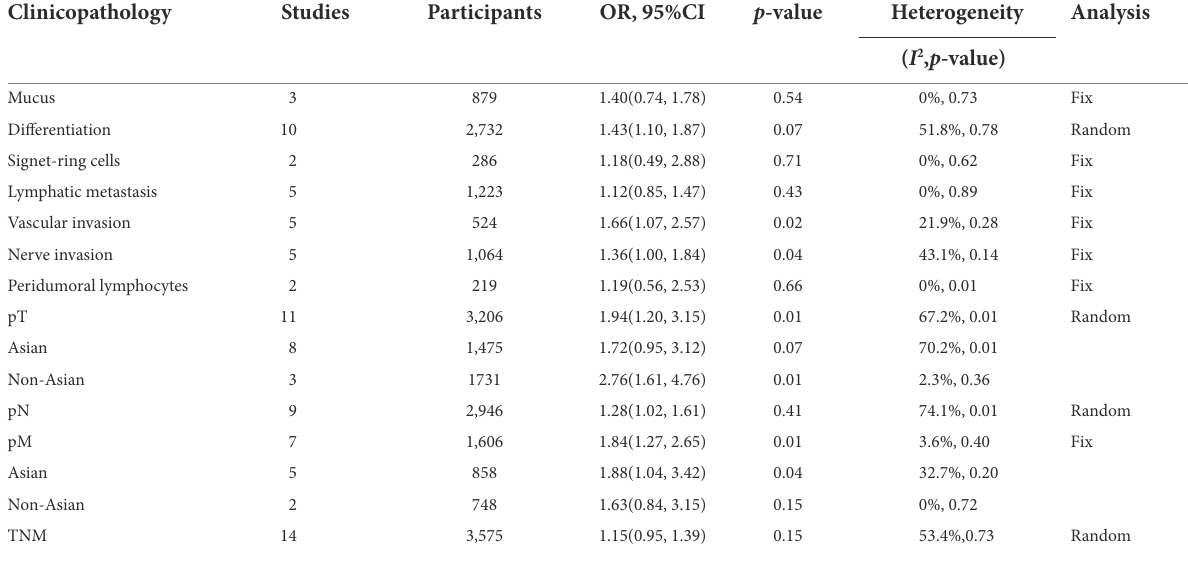
TABLE 2 The correlation between Fusobacterium nucleatum and the clinicopathological features of colorectal cancer.